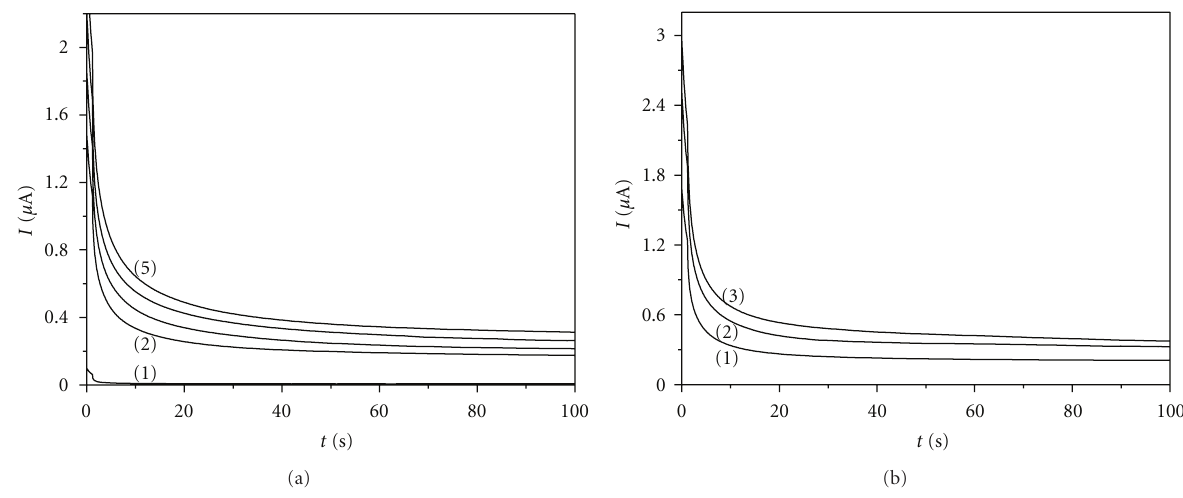
Figure 7: (a) Chronoamperograms, at one potential level, +0.9V versus SCE. (1) supporting electrolyte; (2) 0.2/50 dilution of Aspirin initial solution in supporting electrolyte; (3) 0.2/50 dilution of Aspirin initial solution in supporting electrolyte and ASA addition, 0.01mM ASA final supplementary concentration; (4) 0.2/50 dilution of Aspirin initial solution in supporting electrolyte and ASA addition, 0.02mM ASA final supplementary concentration; (5) 0.2/50 dilution of Aspirin initial solution in supporting electrolyte and ASA addition, 0.03mM ASA final supplementary concentration; supporting electrolyte: 0.1M Na 2 SO 4 pH 7; currents read at 100s. (b) Chronoamperograms, at one potential level, +0.9V versus SCE. (1) 0.2/50 dilution of Acid Acetilsalicilic initial solution in supporting electrolyte; (2) 0.2/50 dilution of Acid Acetilsalicilic initial solution in supporting electrolyte and ASA addition, 0.02mM ASA final supplementary concentration; (3) 0.2/50 dilution of Acid Acetilsalicilic initial solution in supporting electrolyte and ASA addition, 0.03mM ASA final supplementary concentration; supporting electrolyte: 0.1M Na 2 SO 4 pH 7; currents read at